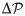
Relative uncertainty between calculated and simulated uncertainty of the power spectrum.The relative deviation between the theoretical uncertainty ΔP and the Monte-Carlo simulated uncertainty ΔPMC, ΔMC=(ΔP-ΔPMC)/ΔPMC of the Boat image (Fig 4). Note that the spectrum values are shifted such that low frequencies are located in the origin and that the original image was used here.